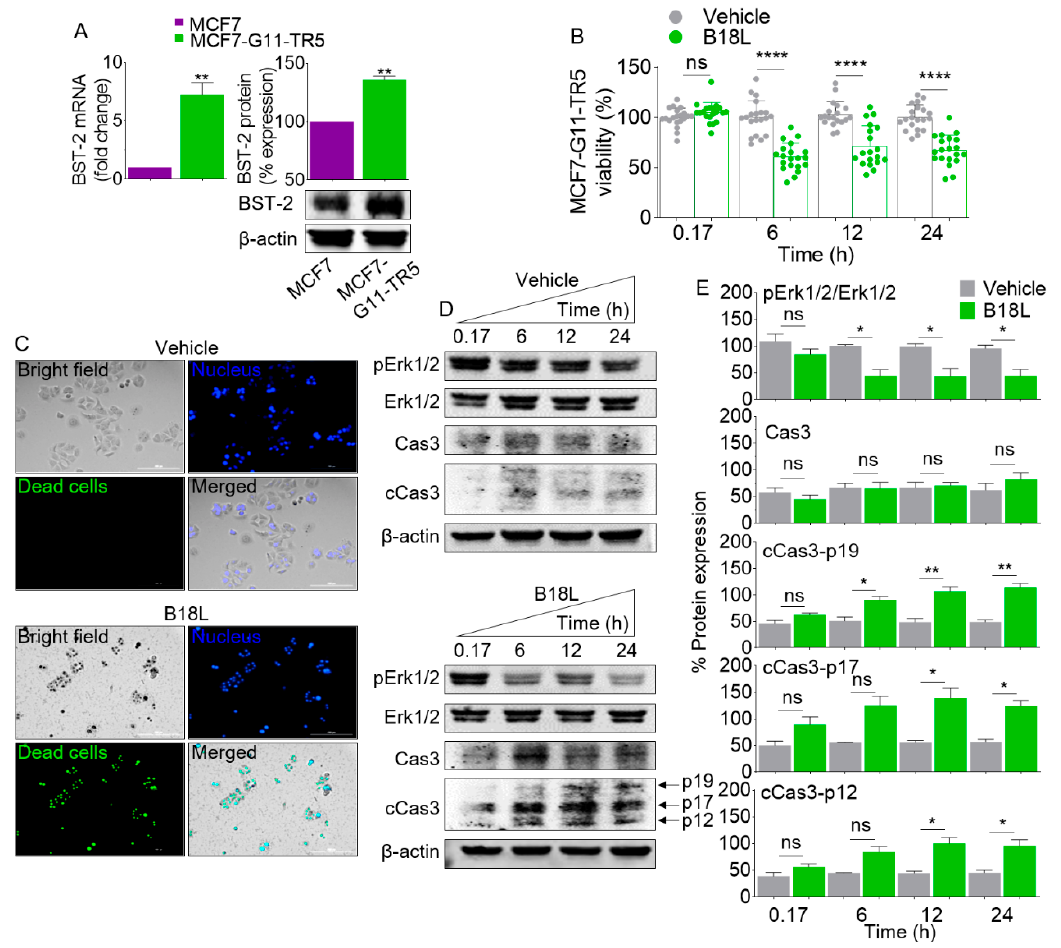
Figure 4. Time-dependent response of MCF7-G11-TR5 cells to B18L: ( A ) Levels of BST-2 mRNA and protein in MCF7 and MCF7-G11-TR5 cells. Difference in BST-2 is presented as fold change relative